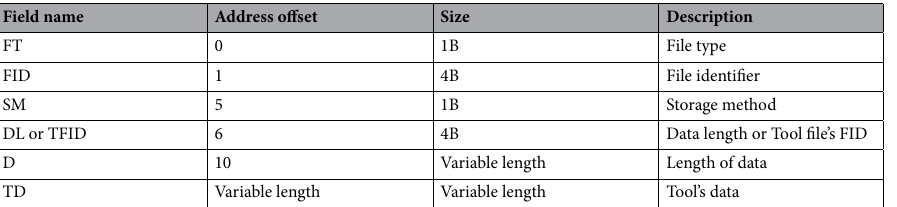
Table 1. Data file format. FT means file type, which is either data file or tool file. FID uniquely identifies a file with an 1-to-1 mapping to its file name. SM represents three kinds of storage methods— unprocessed file ( OF ), continuously processed file ( CPF ), and non-continuously processed file ( SPF ). If a file is OF , field D stores its data, otherwise, if it is CPF , then the next field is DL , specifying the length of the processed data, if it is SPF , the next field is TFID , which means the FID of the used tool file. The last field TD is variable length, if it is CPF , TD means tool data, else the last field length is set to 0.